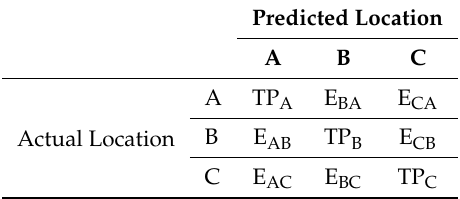
Figure 2. An example of a Receiver Operating Characteristic (ROC) curve for a moderately well-separated dataset. For comparison, the line of no discrimination is indicated by the dashed line along the diagonal. Table 2. Exemplar confusion matrix for damage